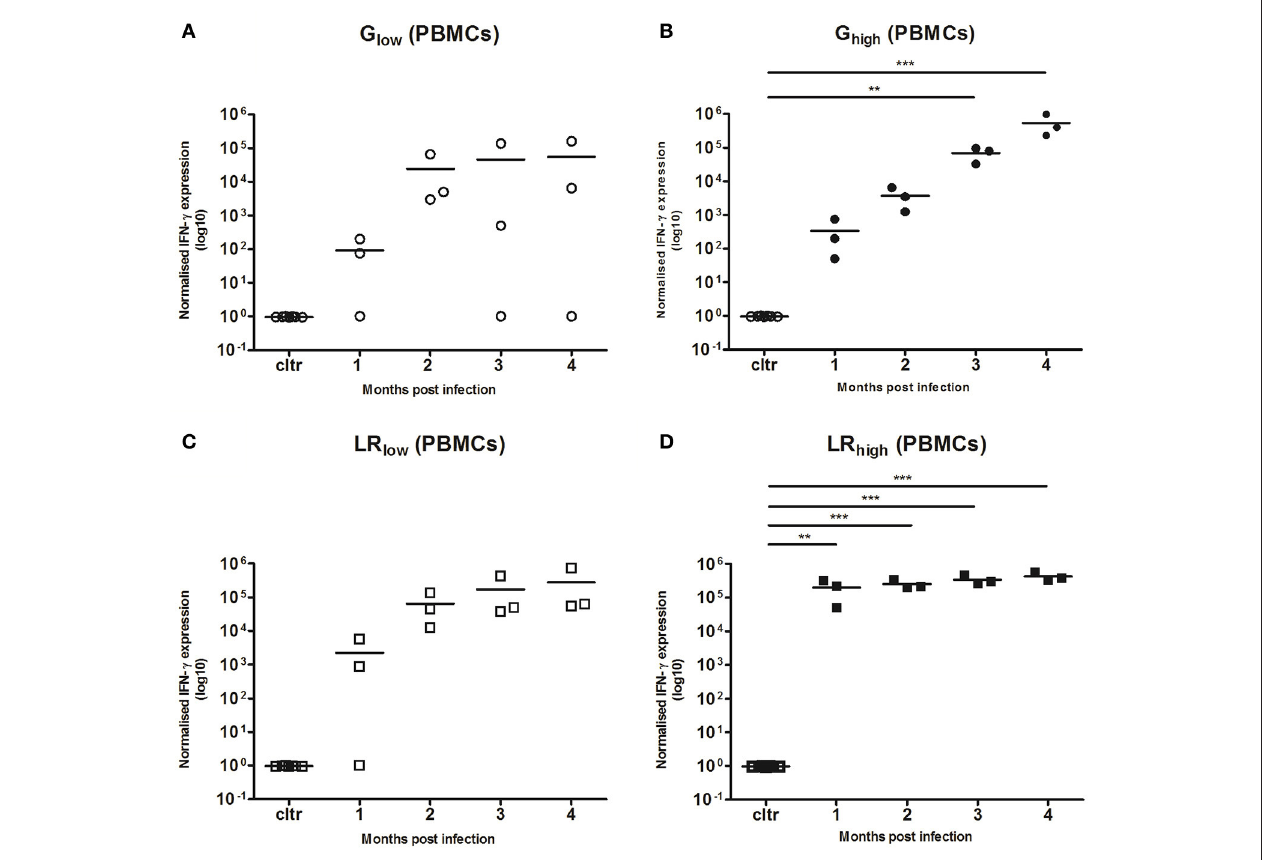
FIGURE 4 | Relative normalized IFN- γ expression in PBMCs after a single IPB-G or IPB-LR inoculation. PBMCs were isolated monthly from pigs orally infected with (A) a low or (B) a high dose of the IPB-G strain (G low and G high ) or (C) a low or (D) a high dose of the IPB-LR strain (LR low and LR high ). Cells were restimulated in vitro with TLA and IFN- γ mRNA was quantified with RT-PCR. The thick lines indicate the group mean. The significance level: ** P < 0.01; *** P <